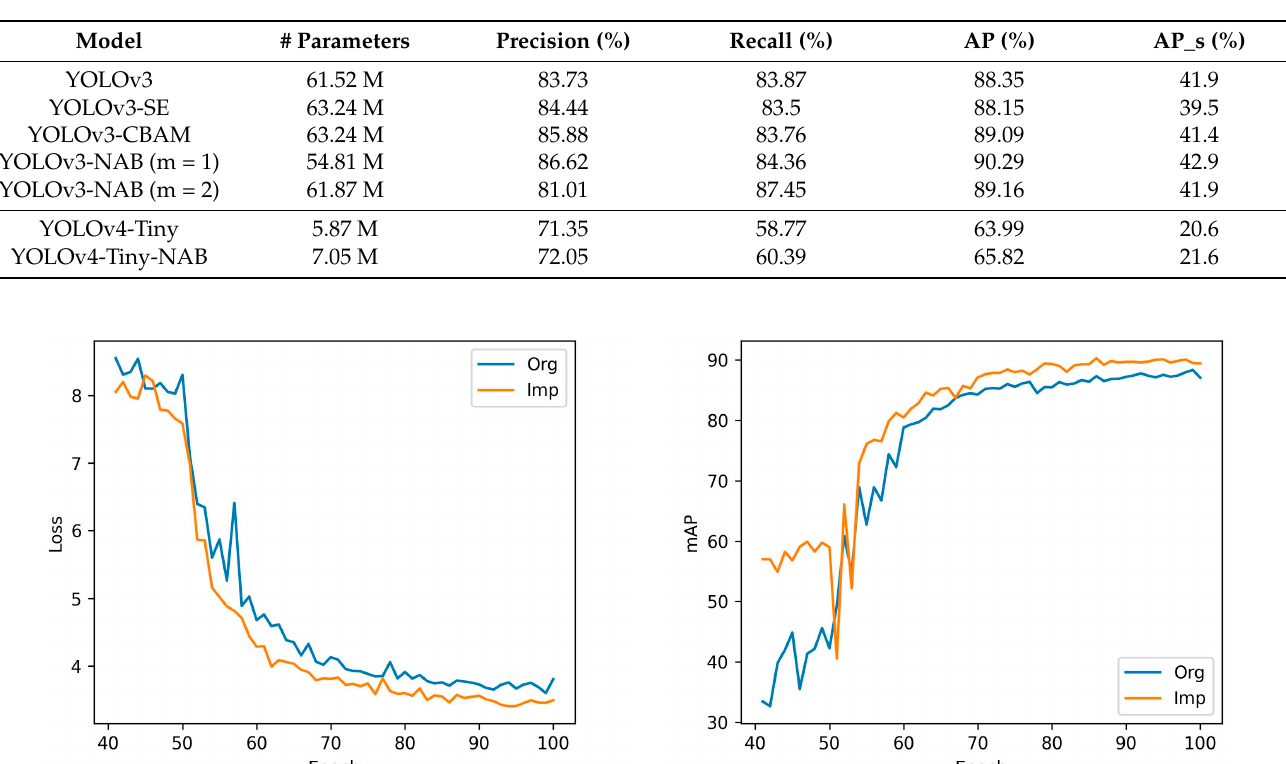
Table 2. Detection results on VHRAI. For a fair comparison, the models based on YOLOv3 had the same configuration. The models based on YOLOv4-Tiny also had the same configuration. YOLOv3- SE and YOLOv3-CBAM adopted the improved ‘CBL5 ′ with attention mechanisms in Figure 8b.